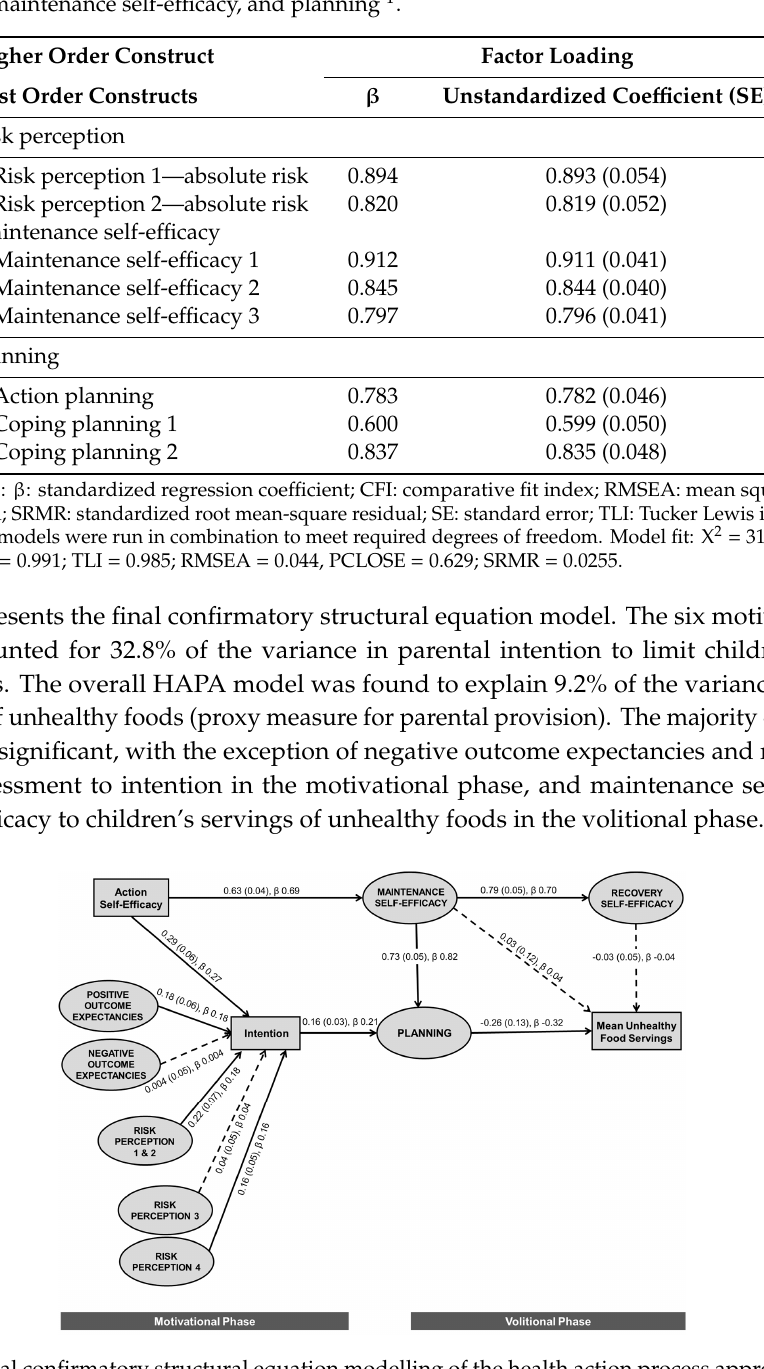
Figure 1. Final confirmatory structural equation modelling of the health action process approach model with unstandardized and standardized regression coefficients. Model fit: X 2 = 210.033, df = 83, p < 0.001; CFI = 0.956; TLI = 0.936; RMSEA = 0.056, PCLOSE = 0.153; SRMR = 0.0601. Model explains 9.2% of the variance in mean unhealthy food servings. Weights presented as: unstandardized regression coefficient (standard error), standardized regression coefficient; rectangles represent measured constructs; ellipses represent latent constructs; solid line indicates statistically significant relationship ( p < 0.05); dashed line indicates non-significant relationship.